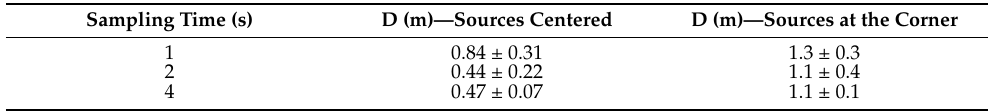
Table 7. Average and SD of the distance (D) between the MLE estimated position and the true source position using the gamma-ray counts of EJ-200 scintillator considering 137 Cs sources of 4 MBq placed at the center and at the bottom corner of the shipping container.